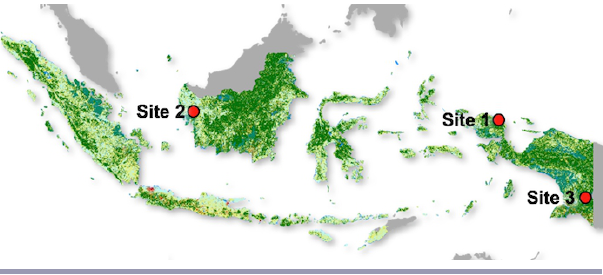
Fig. 1 . Location of research sites in